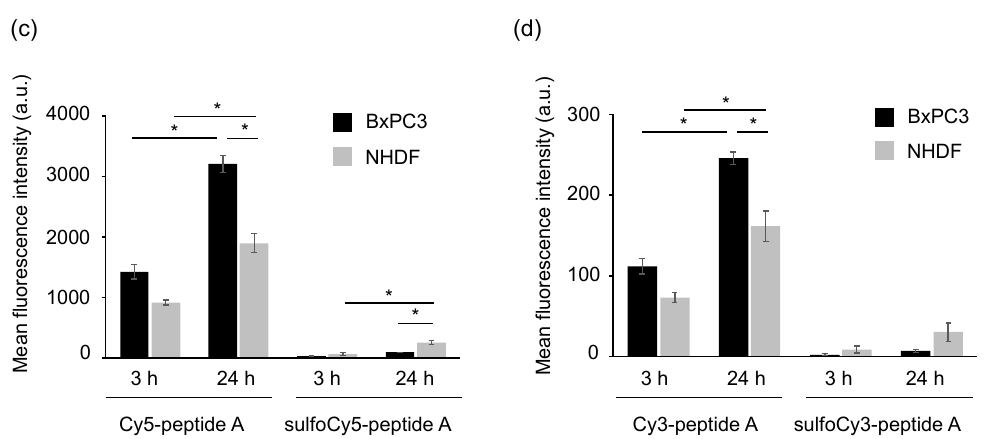
Figure 4. Flow cytometry of BxPC3 and NHDF cells treated with dye-peptide A. The histograms of ( a ) Cy5/sulfoCy5-peptide A and ( b ) Cy3/sulfoCy3-peptide A. The analysis of ( c ) Cy5/sulfoCy5-peptide A and ( d ) Cy3/sulfoCy3-peptide A. Cells were incubated with 0.1 μ M dye-peptide A at 37 °C for 3 or 24 h before flow cytometry. The data represent the mean ±SEM ( n = 3). The statistical significance was assessed by Tukey-Kramer test (* p < 0.01).